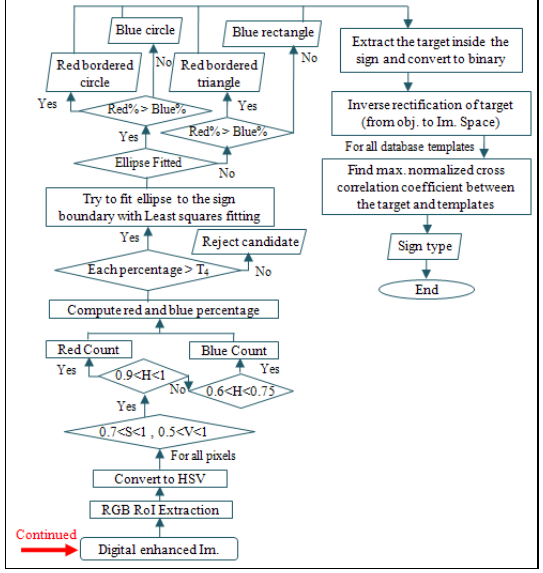
Figure 3. The proposed DRL algorithm